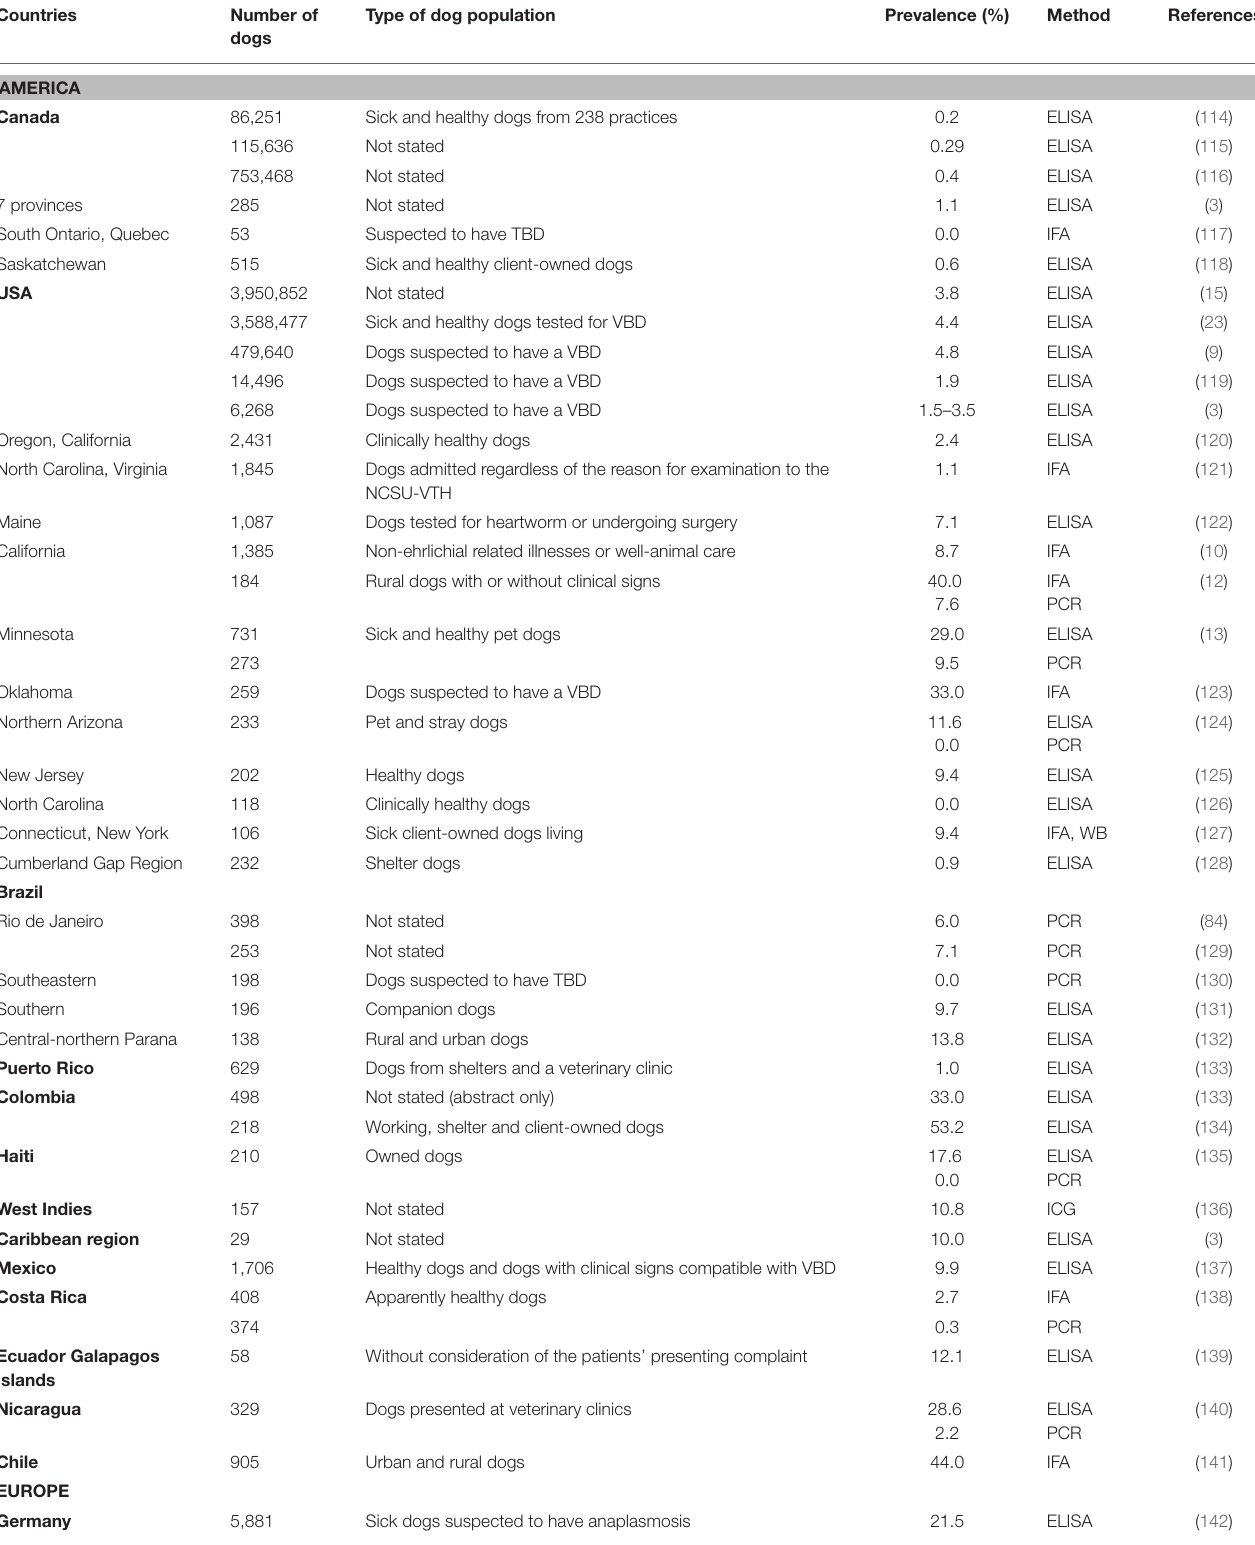
TABLE 1 | Prevalence of Anaplasma spp. ( A. phagocytophilum and A. platys ) antibodies and/or DNA detection of A. phagocytophilum in blood samples from dogs in several countries. Countries Number of